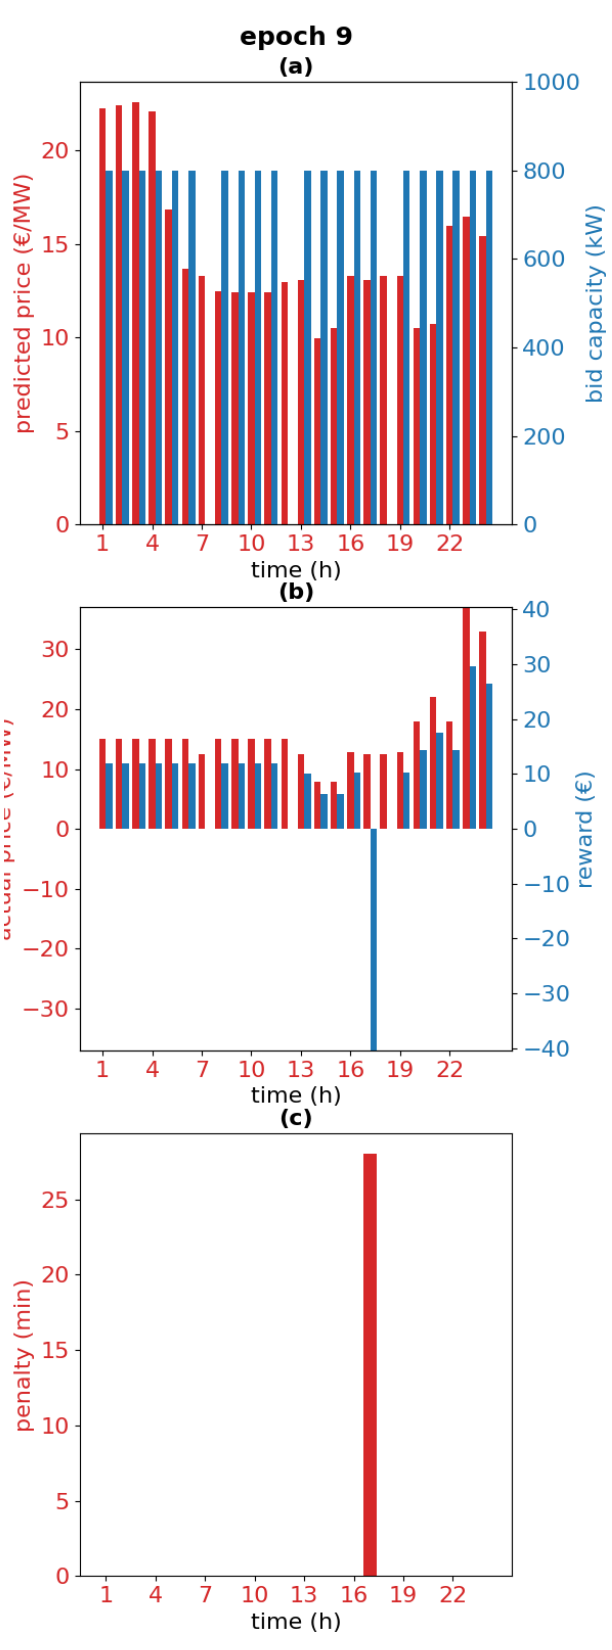
Figure 10. Bids and predicted price ( a ), reward and actual market price ( b ) and penalties ( c ) for the